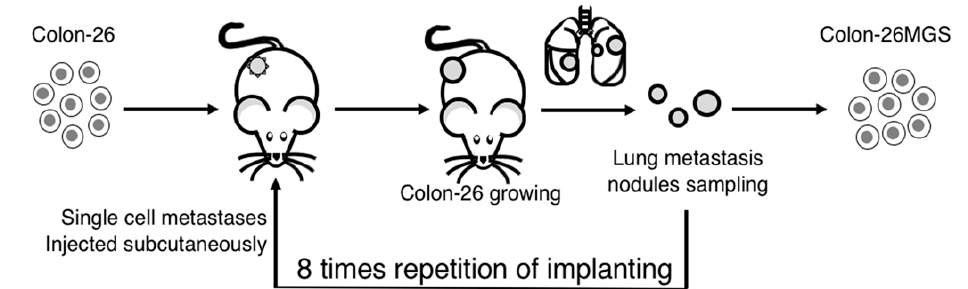
Figure 5. Illustration of the continuous implanting method. Colon-26 cells were grown subcutaneously in right hind paws of BALB / c mice. One month later, the mouse was sacrificed and lung metastases nodules were collected. The metastatic nodules were digested into single-cells and injected again into naïve BALB / c mice in the same manner. After eight repetitions of this process, a highly metastatic Colon-26MGS subline was established.